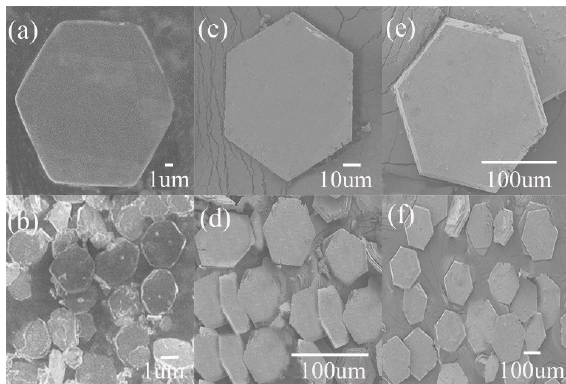
Figure 1. SEM images of ( a , b ) KFO-20, ( c , d ) KFO-80, and ( e , f ) KFO-180.